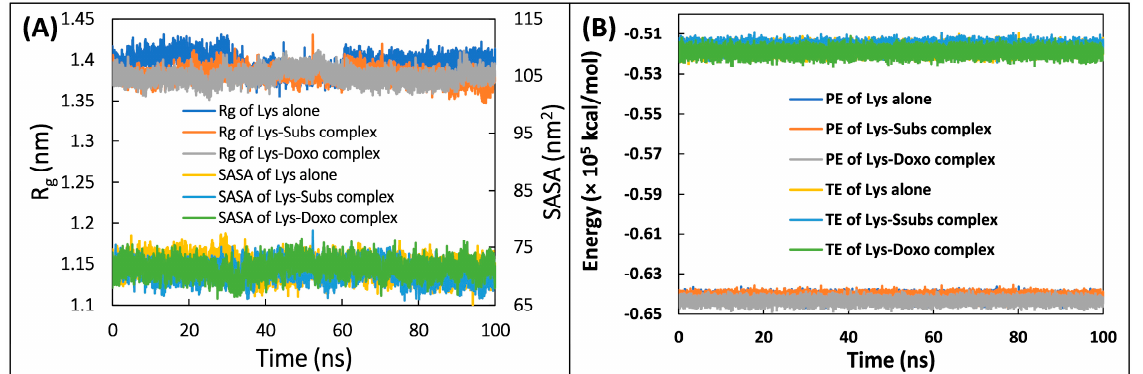
Figure 7. ( A ) Solvent accessible surface area (SASA) and radius of gyration (Rg) of lysozyme alone, lysozyme–substrate complex, and lysozyme–doxofylline complex as a function of simulation time. ( B ) Potential energy (PE) and total energy (TE) of lysozyme alone, lysozyme–substrate complex, and lysozyme–doxofylline complex as a function of simulation time.